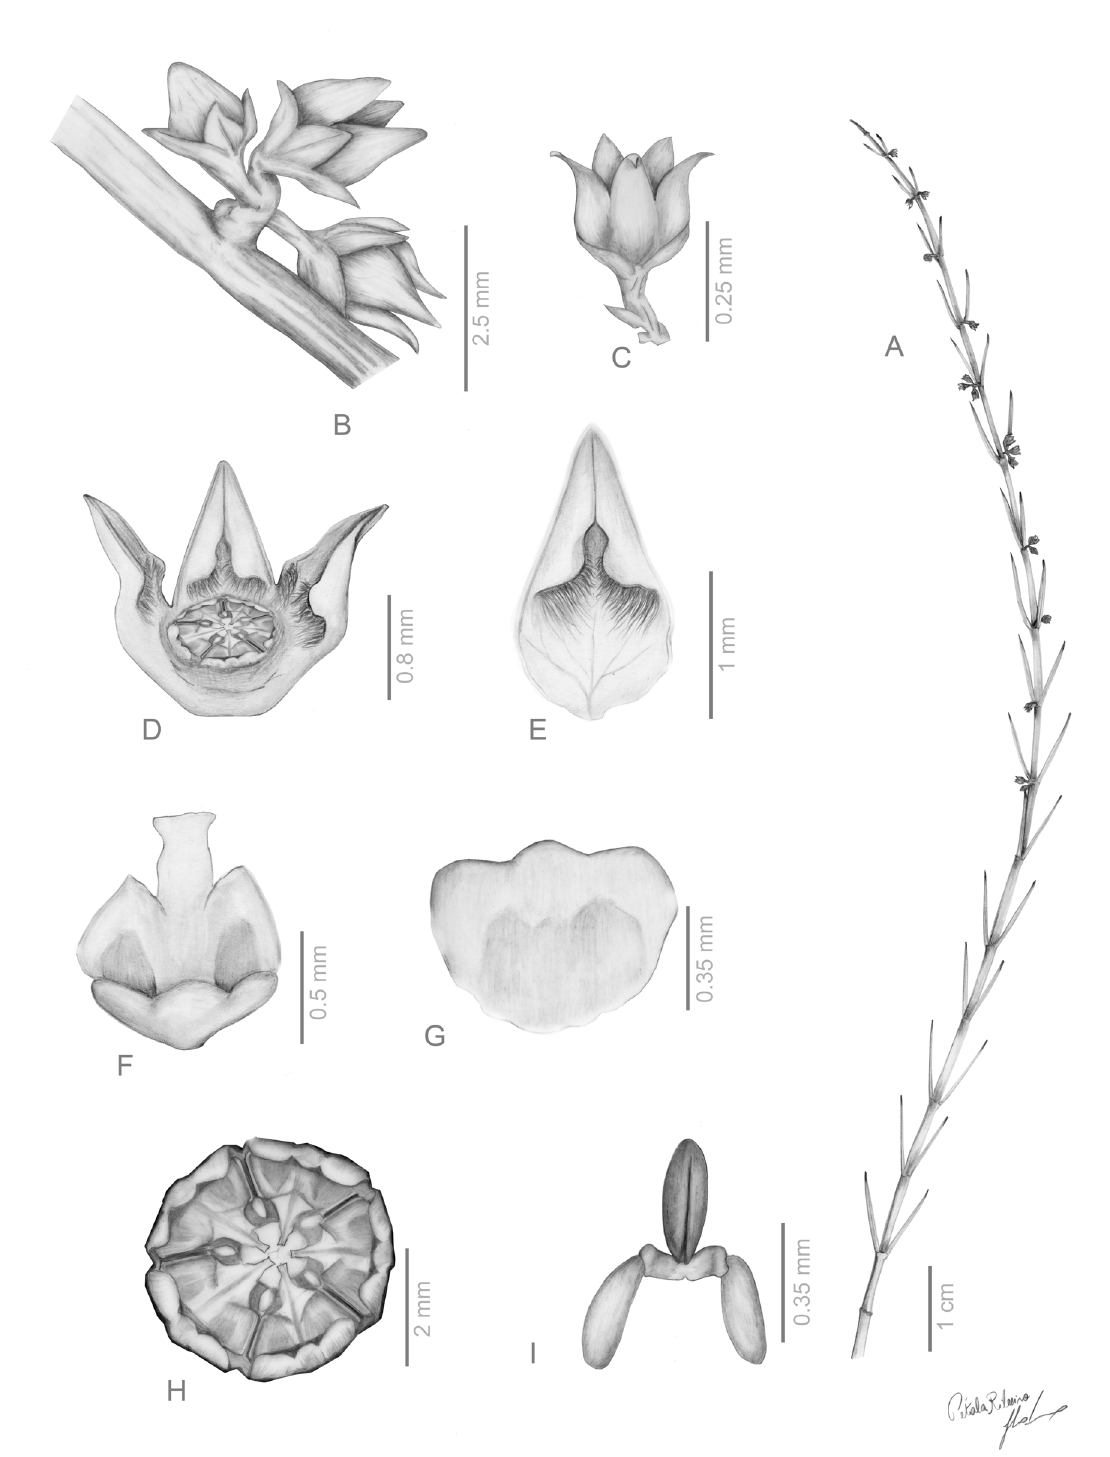
Fig. 1. Hemipogon trilobatus Bitencourt & Rapini sp. nov. A . Habitus. B . Cyme with two flowers and a bud. C . Flower. D . Flower with calyx and two corolla lobes removed to show the gynostegium. E . Corolla lobe, adaxial view. F . Anther with a staminal corona lobe basally attached. G . Corona lobe showing the 3-lobed apex, adaxial view. H . Gynostegium, viewed from above. I . Pollinarium. Drawn by Pétala Gomes Ribeiro from the holotype